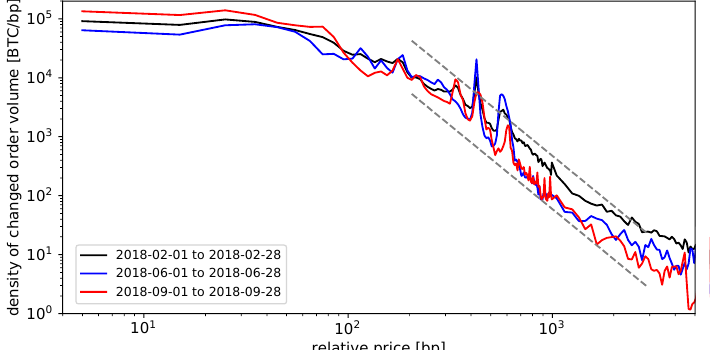
Figure 10. Distribution of changed limit order volume. We plot the time-averaged empirical density of changed limit order volume in the limit order book (Equation (14)) on a relative price scale. The three plots correspond to different four-week periods of our data. The dashed lines have a slope of − 2.8.